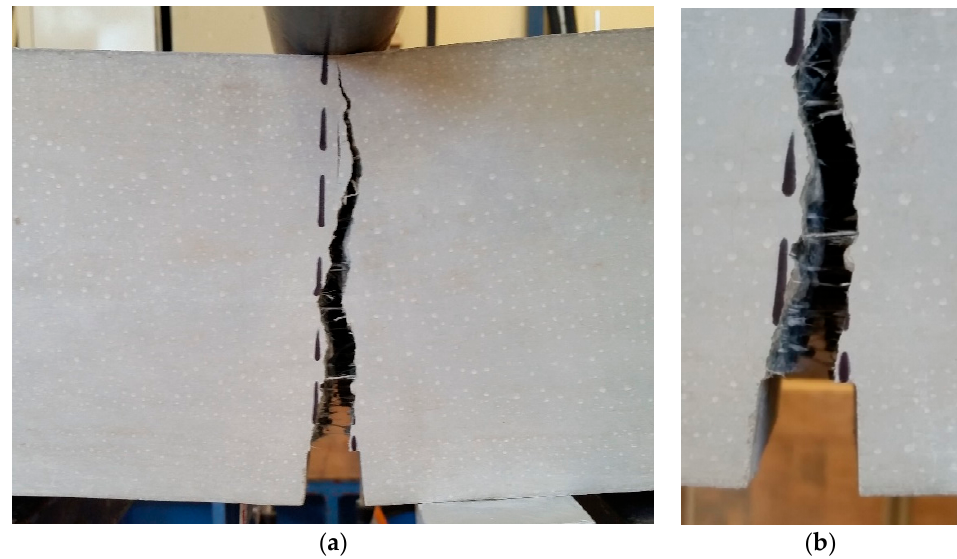
Figure 5. ( a ) Fibers bridging the crack; ( b ) Zoom on the wider section of the crack.